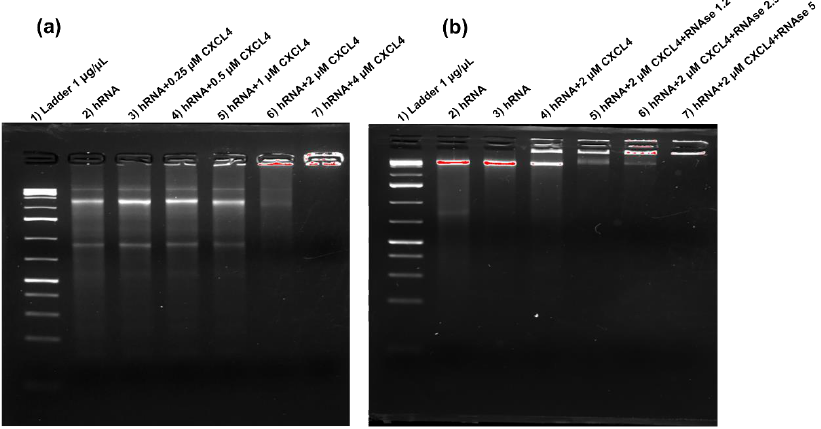
Figure 1. CXCL4 binds self-RNA in a dose-dependent manner and protects it from enzymatic degradation. ( a ) Human RNA at different concentrations was incubated for 30 min at 37 °C with different μMolar concentrations of CXCL4. The complexes were subsequently loaded onto 2% agarose and the RNA was colored with SYBR Green. Delayed RNA migration indicates the binding of CXCL4 to the RNA. ( b ) The RNA was incubated with CXCL4 in the presence or absence of different doses of RNAse. The DNA bound to CXCL4 is protected from degradation. Experiments in (a) and (b) were repeated 2 times.